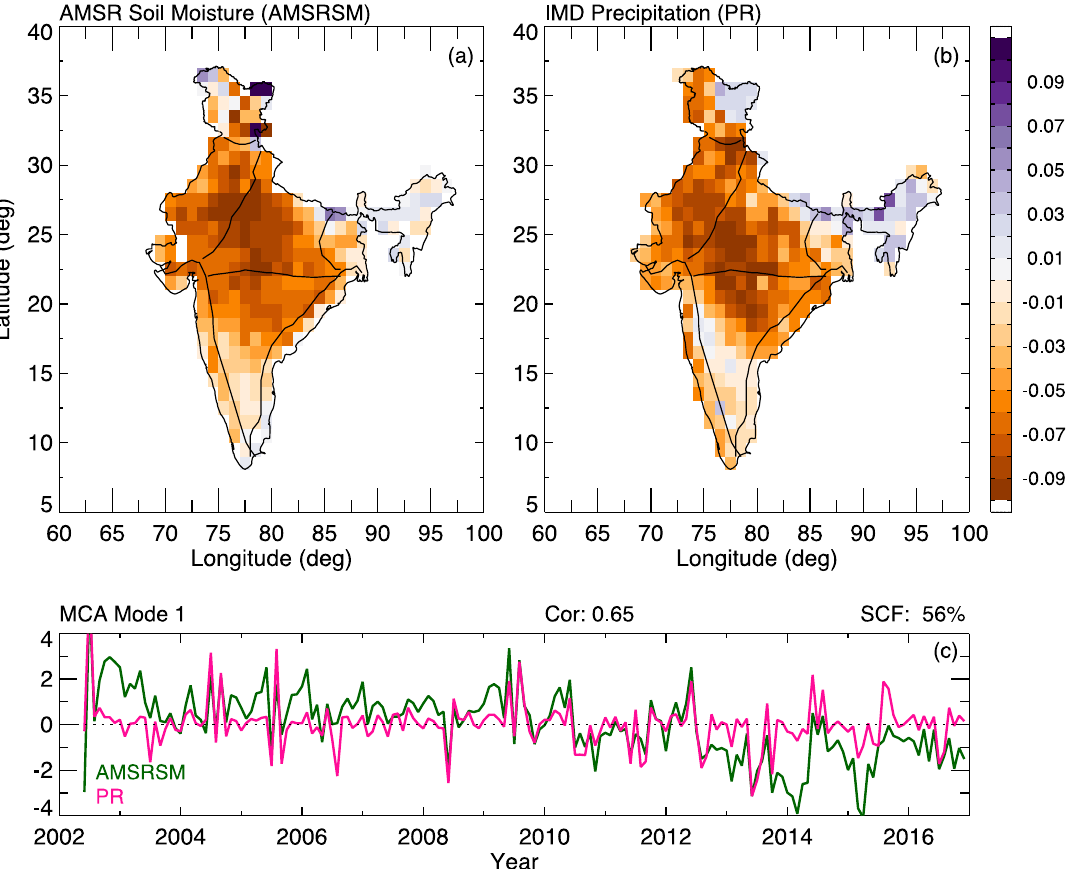
Figure 4. Spatial patterns of the first MCA mode associated with ( a ) AMSR soil moisture (AMSRSM) and ( b ) IMD precipitation (PR) during the period 2006–2016. ( c ) The corresponding covariance coefficients associated with AMSR soil moisture (green curve) and precipitation (pink curve). The squared coefficient factor (SCF) and correlation coefficients are indicated on the top of the plot.